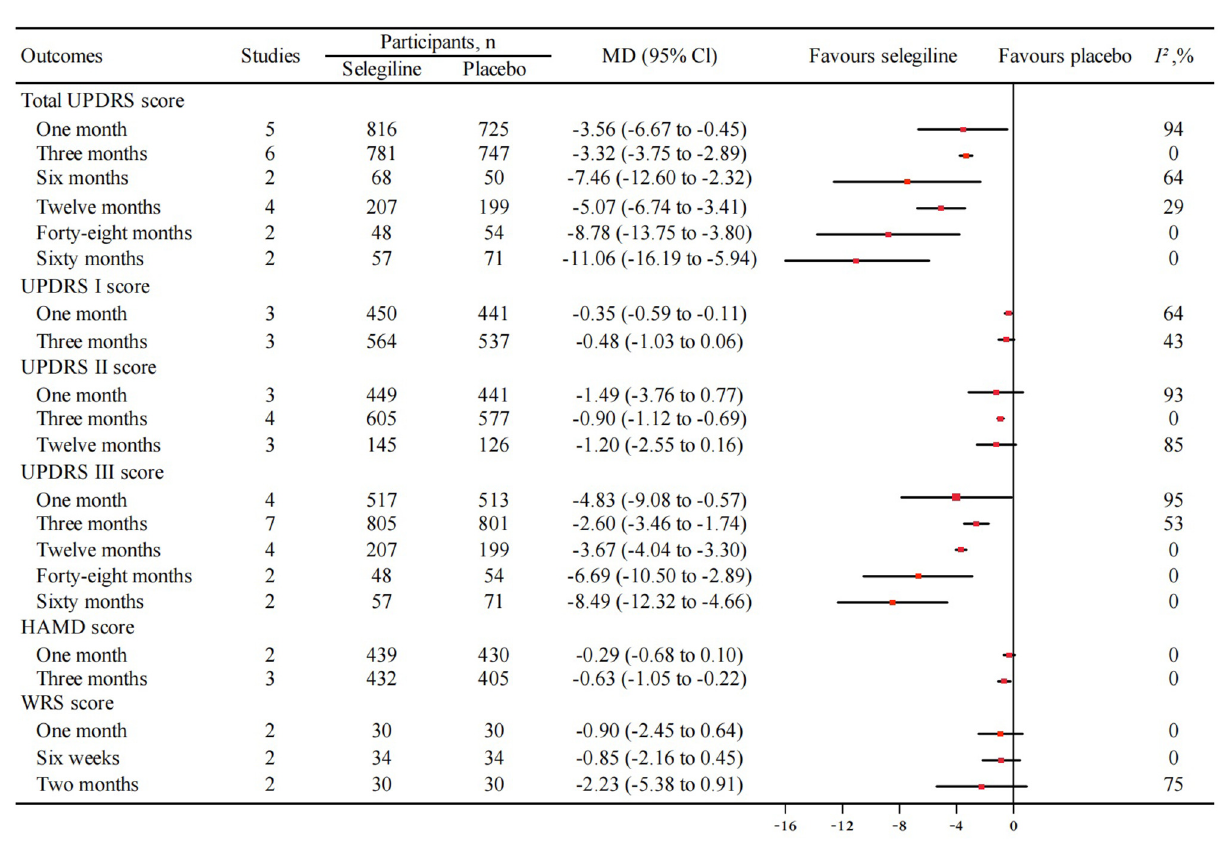
FIGURE3 Meta-analysis of improvement in total UPDRS, UPDRS I, UPDRS II, UPDRS III, HAMD, WRS score between selegiline and placebo. UPDRS, unified Parkinson’s disease rating scale; UPDRS I, mental score; UPDRS II, activities of daily living score; UPDRS III, motor score; HAMD, Hamilton depression rating scale; WRS, webster rating scale; MD, mean difference; 95% CI, 95% confidence